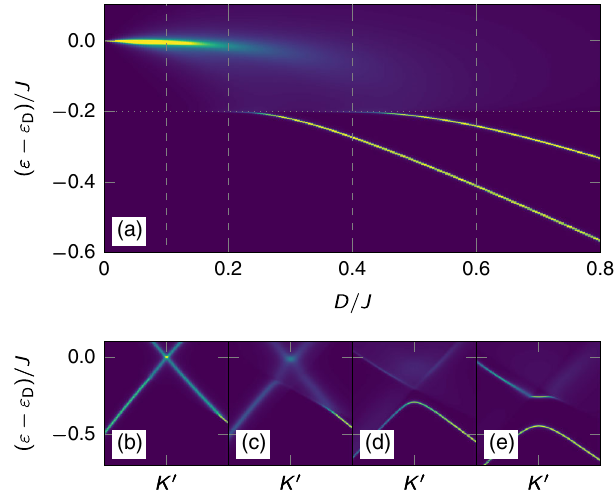
FIG. 11. Topological magnon “ revival ” brought about by strong interactions in the chiral magnet for S ¼ 1 and B= ð JS Þ ¼ 0 . 8 (i.e., B < B ). (a) Spectral function A K 0 ð ε Þ at the K 0 point c as a function of DMI D . Dark blue (bright yellow) color indi- ε Þ . The dotted horizontal line at cates zero (maximal) A K 0 ð ð ε − ε D Þ =J ¼ − 0 . 2 indicates the lower threshold of the two- magnon continuum, from which the two quasiparticle peaks are expelled at about D=J ¼ 0 . 2 and D=J ¼ 0 . 4 , respectively. Vertical dashed lines indicate D=J ratios for which band structures are shown in the lower panels. (b) – (e) Many-body renormalized magnon band structure along a high-symmetry path in reciprocal space through the K 0 point for (b) D=J ¼ 0 . 1 , (c) D=J ¼ 0 . 2 , (d) D=J ¼ 0 . 4 , and (e) D=J ¼ 0 . 6 .